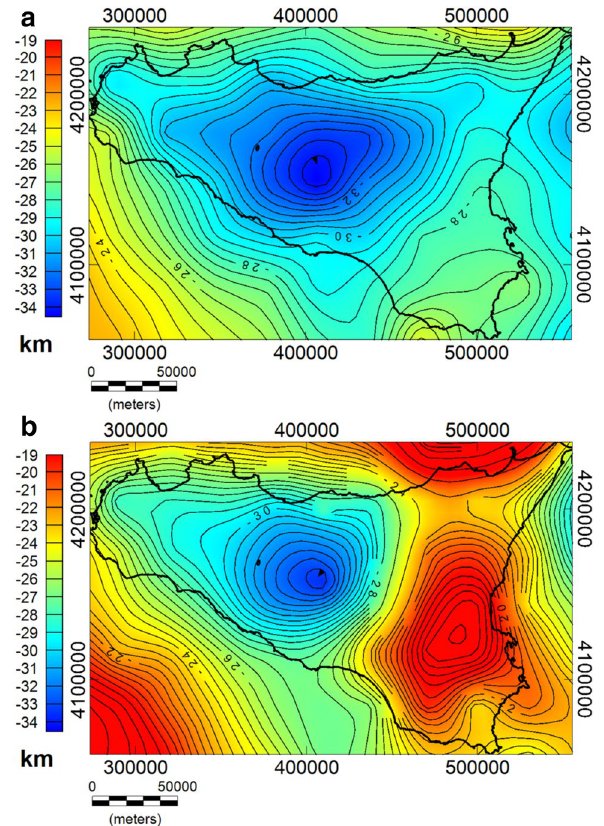
Figure 8. Maps of the gravity-based Moho boundary ( a ) and the magnetic-based Curie Isotherm ( b ) beneath